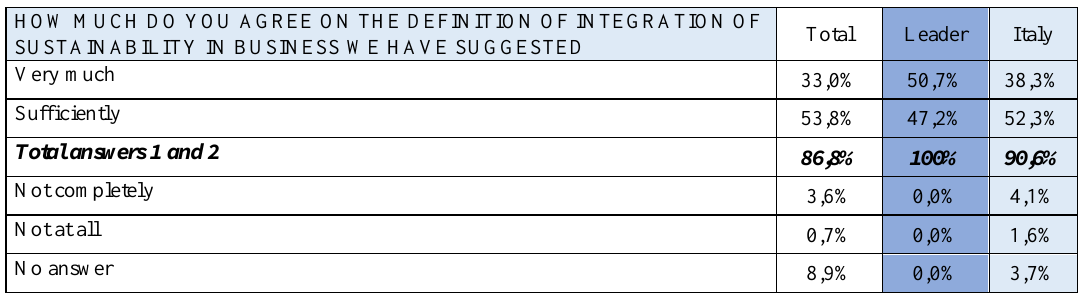
HOW MUCH DO YOU AGREE ON THE DEFINITION OF INTEGRATION OF SUSTAINABILITY IN BUSINESS WE HAVE SUGGESTED